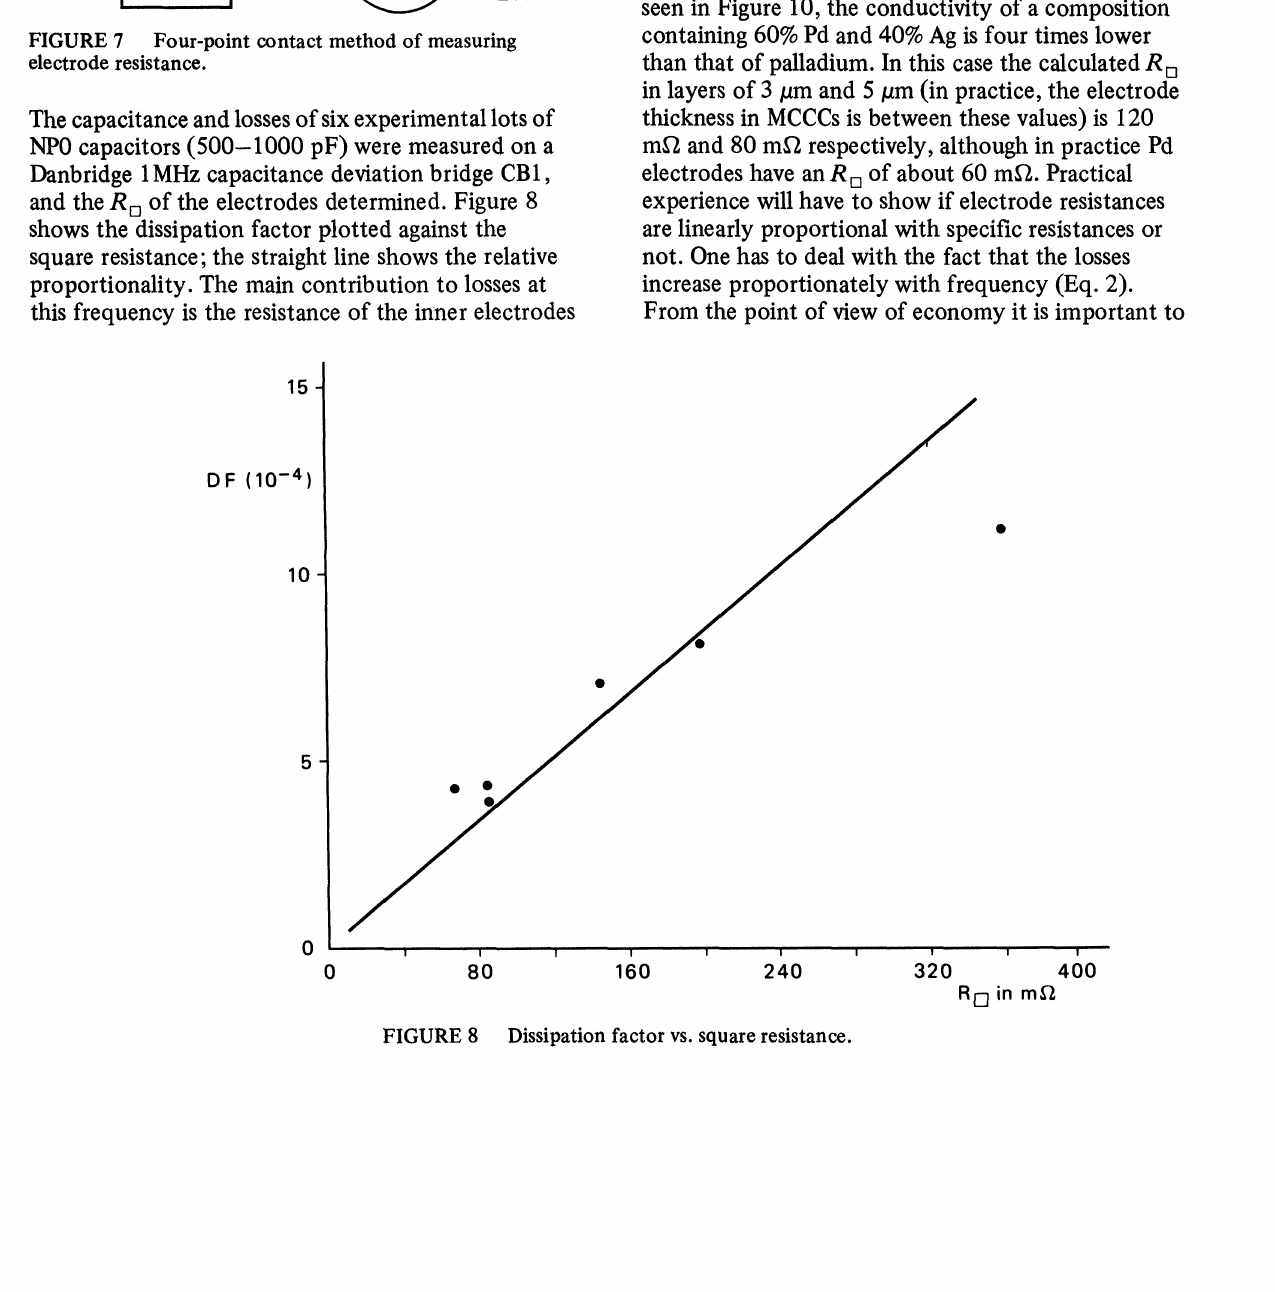
FIGURE 8 Dissipation factor vs. square